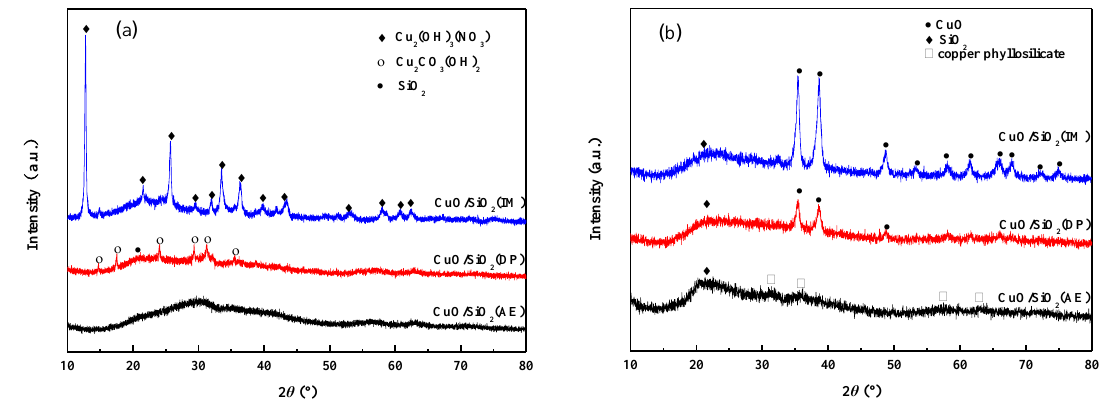
ff raction (XRD) patterns of CuO / SiO Figure 2. X-ray diffraction (XRD) patterns of CuO/SiO 2 catalysts ( a ) before and ( b ) after calcination. Figure 2. X-ray di